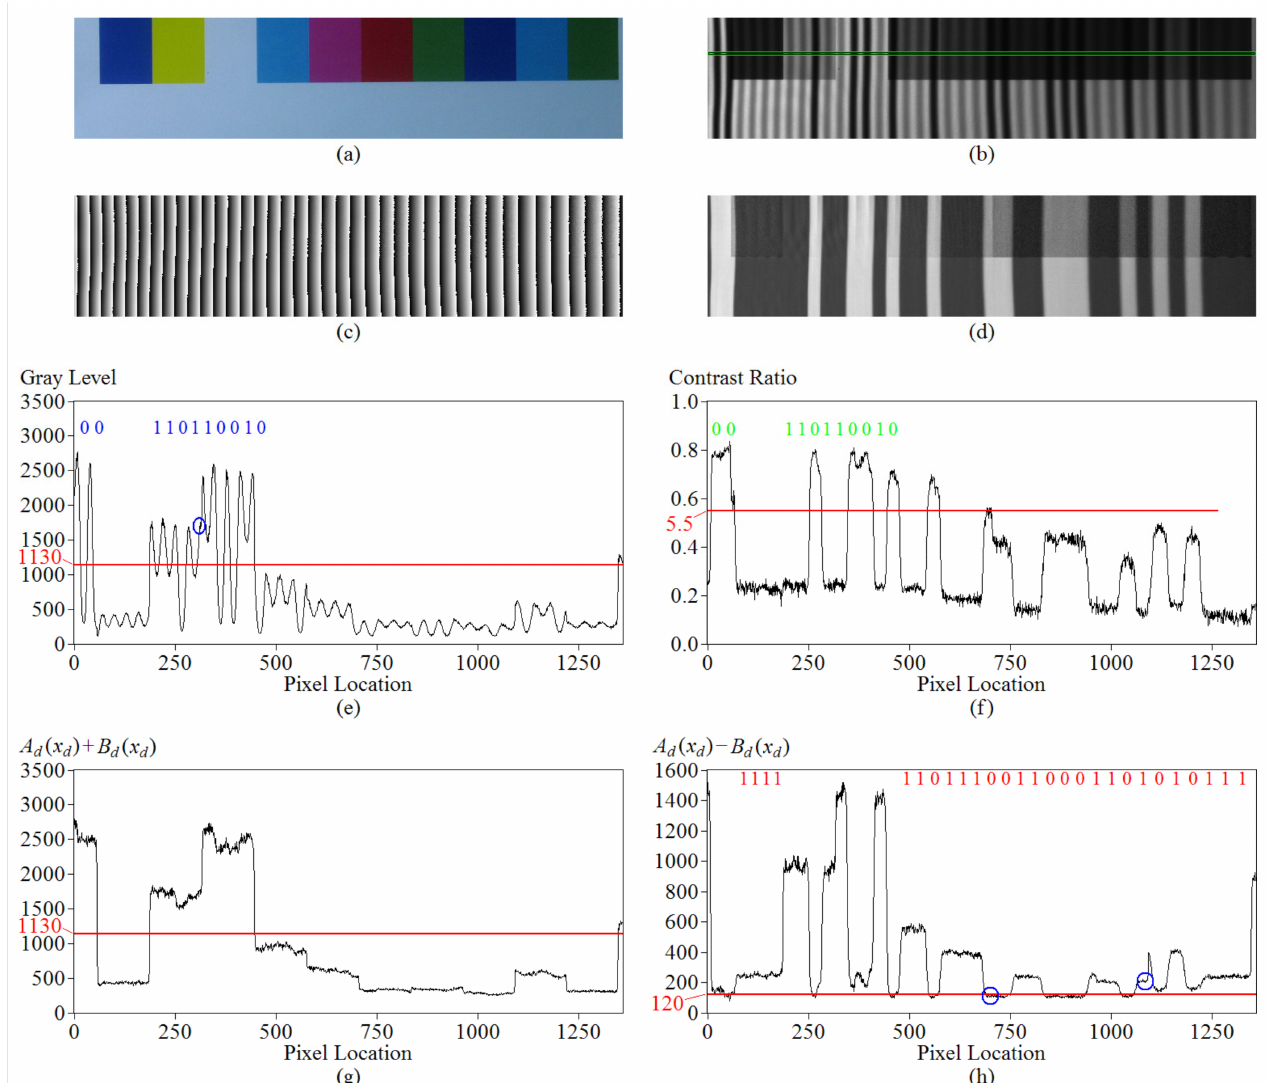
Figure 19. ( a ) An appearance of the inspected surface that was textured with various colors. ( b ) The recorded image for the first pattern projection on the inspected object. ( c ) The extracted phase map. ( d ) The extracted contrast map. ( e ) The gray-level distribution along the image row that is marked with the green frame shown in ( b ). ( f ) The corresponding 1D contrast distribution. ( g ) 1D distribution of A d ( x d , y d ) + B d ( x d , y d ) along the marked image row. ( h ) 1D distribution of A d ( x d , y d ) − B d ( x d , y d ) along the marked image